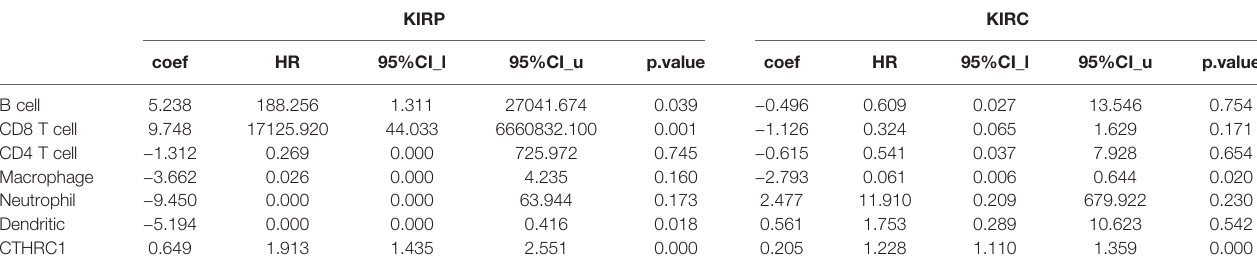
TABLE 2 | The cox proportional hazard model of CTHRC1 and six tumor-in fi ltrating immune cells in KIRP and KIRC (TIMER). KIRP KIRC coef HR